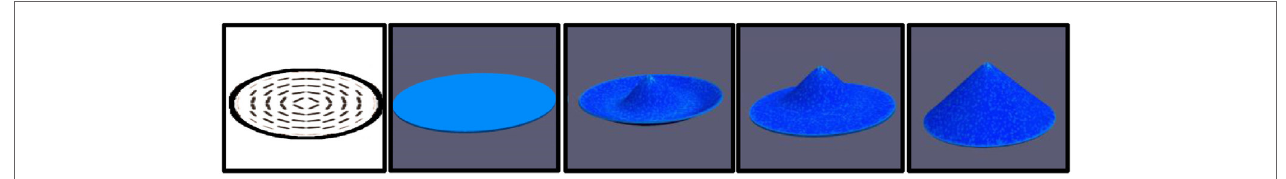
FigUre 2 | Finite element simulation of an lce disk with a + 1 azimuthal defect, on heating . We observe a transient “sombrero” shape with an upward- curving rim. The rim deforms and snaps through, leaving a cone shaped center surrounded by nearly flat annulus. Eventually, the sample reaches the theoretically predicted cone shape (Modes et al.,